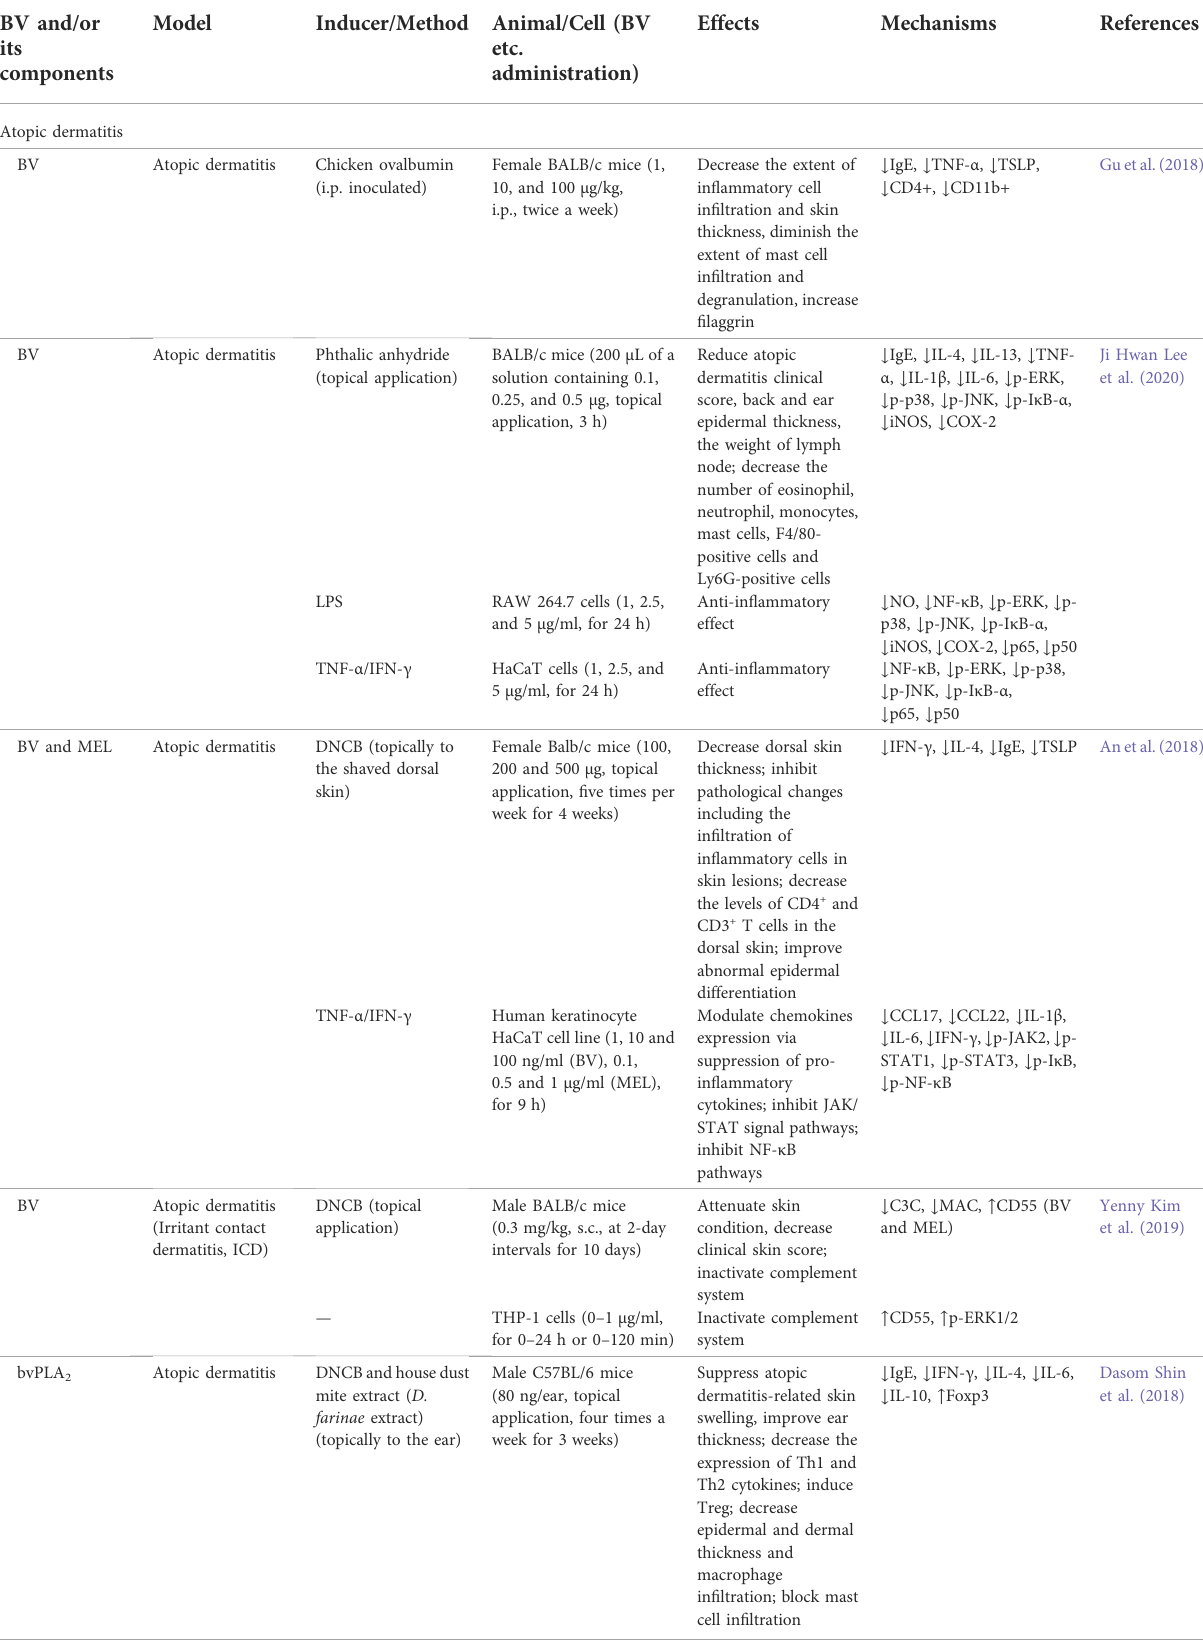
TABLE 3 Summary of the effects and mechanisms of BV and its main components on in fl ammatory diseases. BV and/or